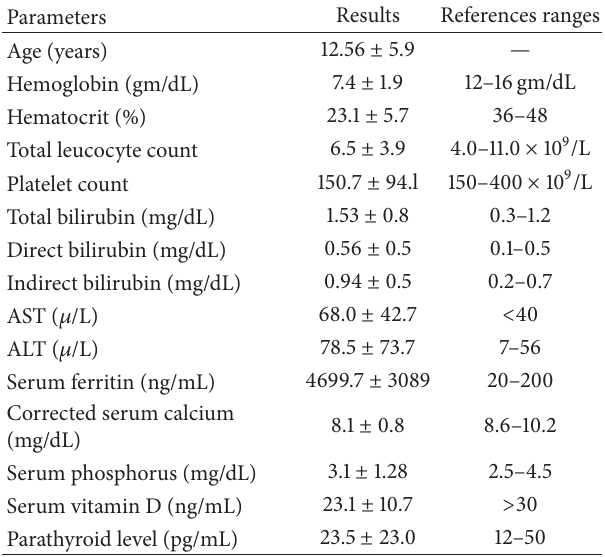
Table 1: Descriptive statistics and laboratory